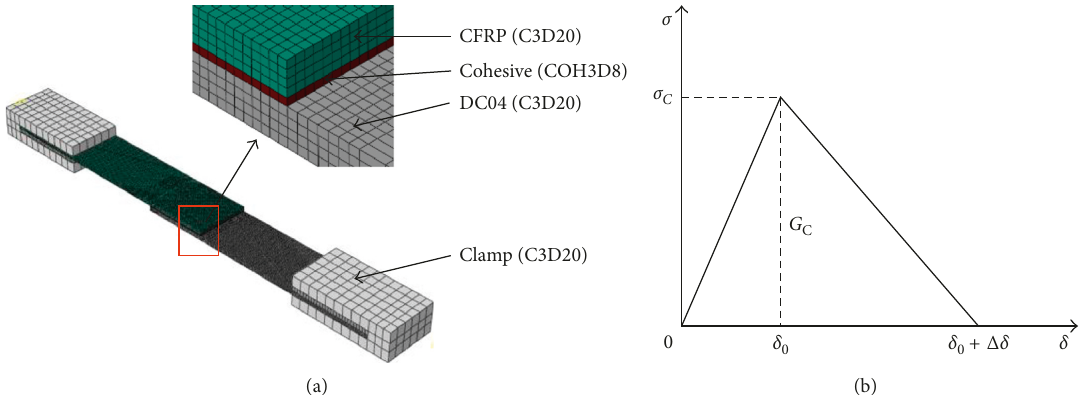
Figure 2: (a) The numerical model and (b) bilinear traction separate law for the finite element